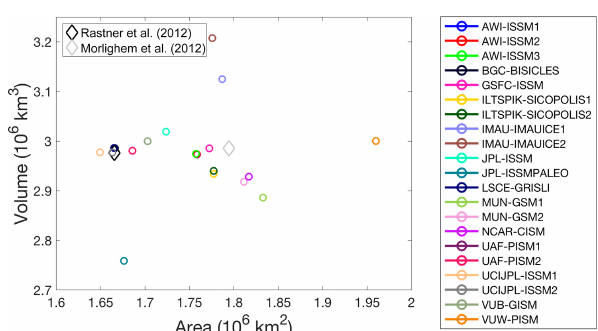
Figure 3. Grounded ice area and grounded volume for all models (circles). Observed values (Morlighem et al., 2017) are given for the entire ice-covered region (light-grey diamond) and for the re- gion of the main ice sheet (black diamond) where loosely connected glaciers and ice caps are removed (Rastner et al.,